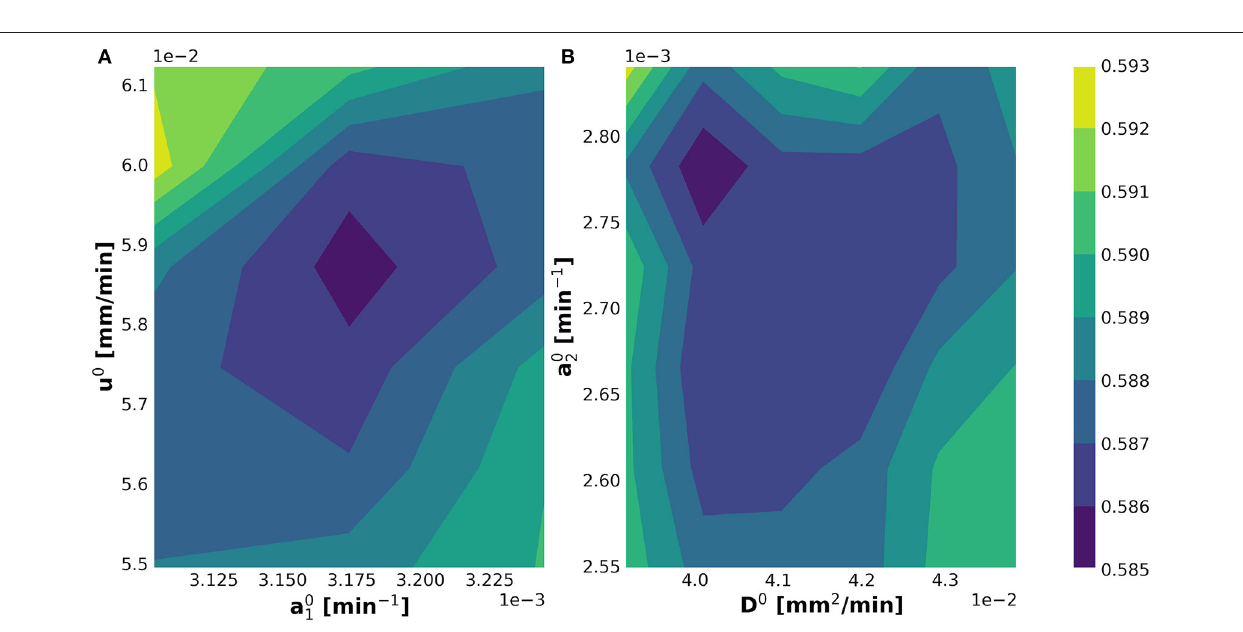
diminished abruptly and became illogically comparable to the numerical dissipation. The L-curve for a 2 followed an opposite trend with respect to a 1 and D , but confirmed the stability after the knee/elbow point ( Figure 5C ). The value of the predicted fluid parameters exhibited also a dependence on α τ , reaching a short plateau at α τ ≈ 0.6 − 0.7 ( Figures 5E–H ). This stable region after the knee/elbow point is the proper choice for α τ . The physical meaning of this external foreach -loop of the KC- DA procedure is better explained looking at the spatial